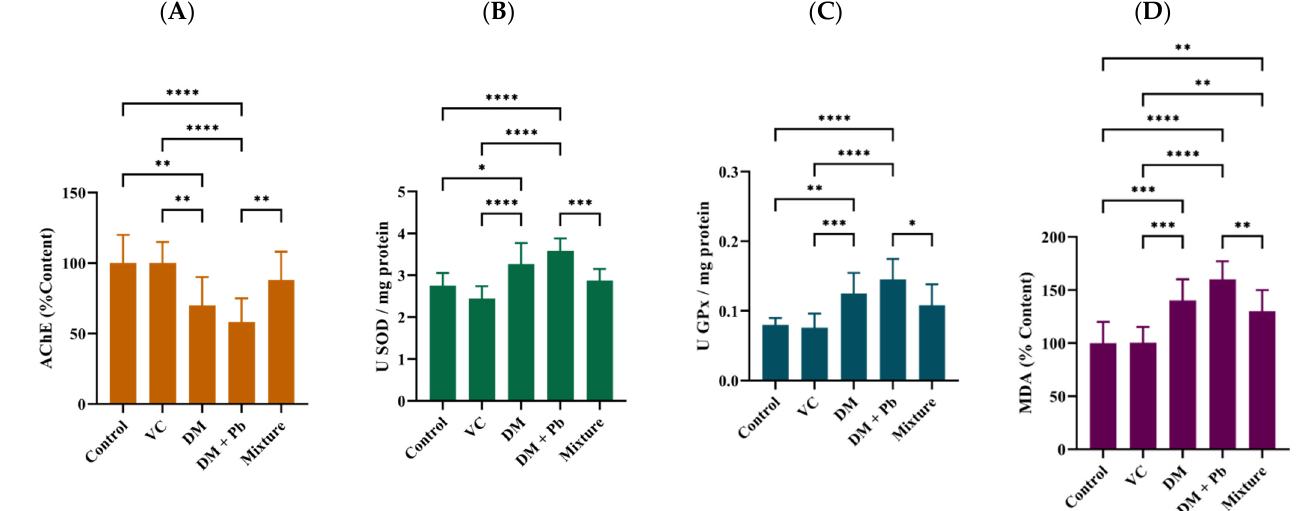
Figure 3. Activity of ( A ) AChE, ( B ) SOD, ( C ) GPx and ( D ) MDA levels in zebrafish following treatment with vitamin C (100 µ g L − 1 ), DM (2 µ g L − 1 ) and Pb (60 µ g L − 1 ) alone and in combination with VC (100 µ g L − 1 ) for 48 h. Values are expressed as means ± SD ( n = 9). Statistically significant differences are denoted by * p < 0.05, ** p < 0.01, *** p < 0.001, **** p < 0.0001 (one-way ANOVA, followed by a Turkey’s test).